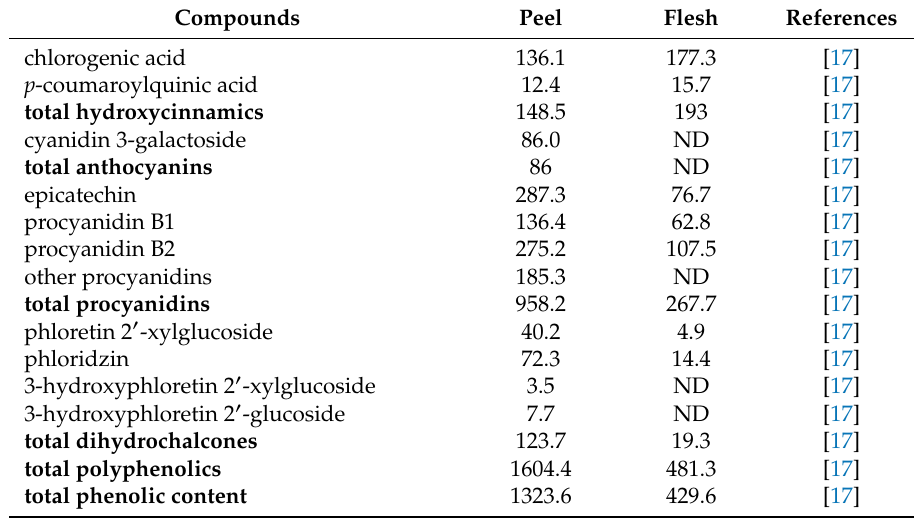
Table 4. Concentrations (micrograms per gram of fresh weight) of phenolic compounds present in apple peel and